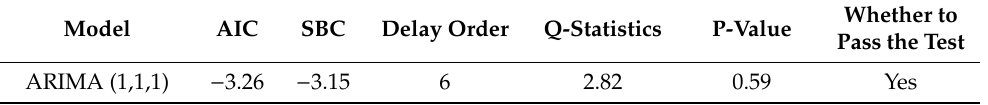
Table 9. Model parameters of ARIMA (1,1,1).